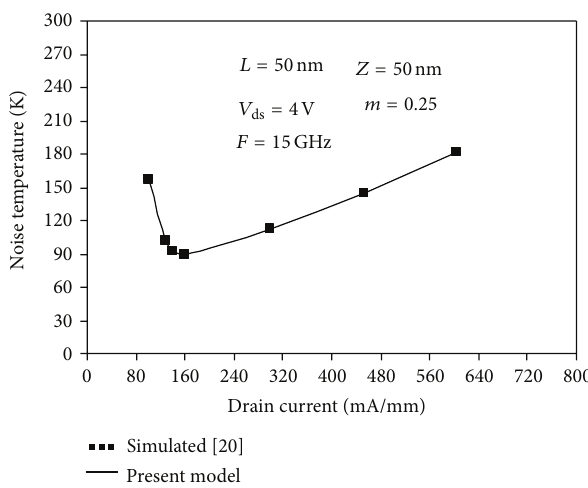
Figure 14: Variation of noise temperature with drain current.